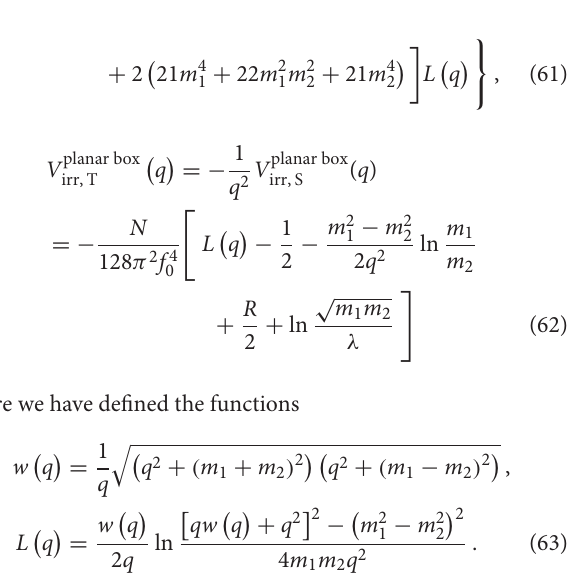
part; it is therefore not part of the potential (see also section